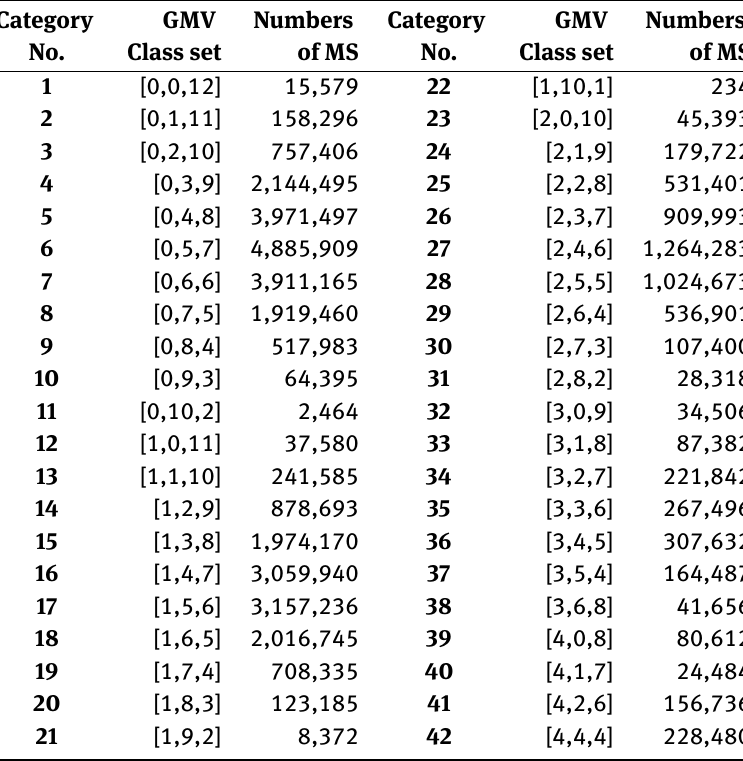
Table 1: Number of basic forms of magic squares of order 5 in each GMV class set